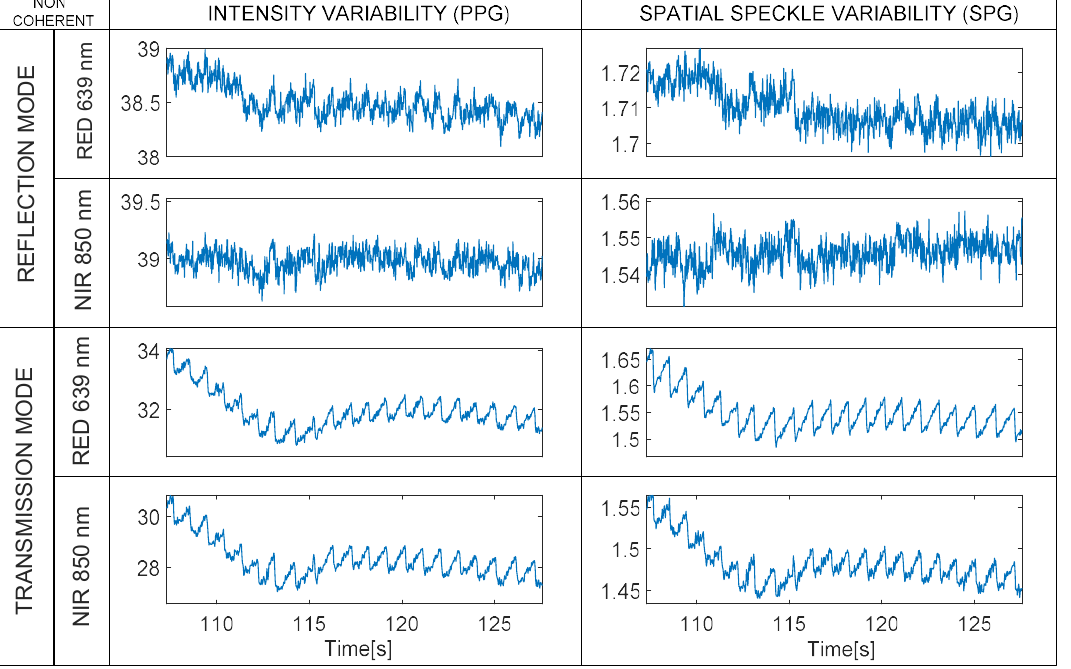
Figure 16. Boxplots of quality index of rSPG signals with 4 different lights at 5 integration times with non-coherent light in transmission and reflection. The inner box divisions indicate: Q1 (the first quartile) to Q3 (the third quartile). The median is marked by a line across the box. The “whiskers” indicate results from Q1 and Q3 to the most extreme data points. The + symbols represent outliers. 4.2. Results of Regression Analysis between rPPG and ITA and rSPG Regression tests (using Matlab’s Polyfit and Polyval) are shown for rPPG vs. rSPG signals (Figure 17 and Table 4), and rPPG vs. ITA signals (Figure 18 and Table 5) for all integration times. The input data used for these tests were synchronous because the three signals (rPPG, rSPG, and ITA) were always produced from the same video streams. We